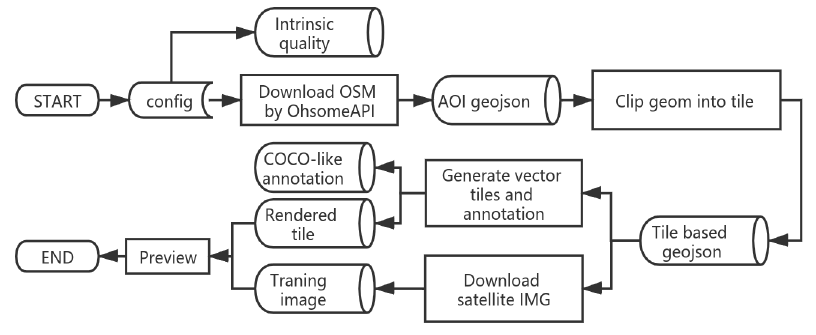
Figure 1. The workflow of ohsome2label as a prototype of the proposed conceptual